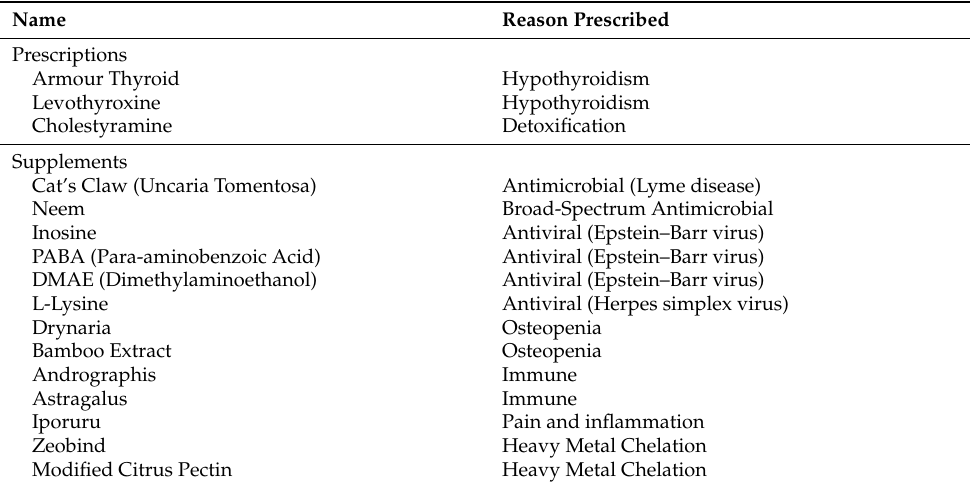
Table 4. Medications Prescribed during Phase 2 of Treatment (February 2015–August 2017).